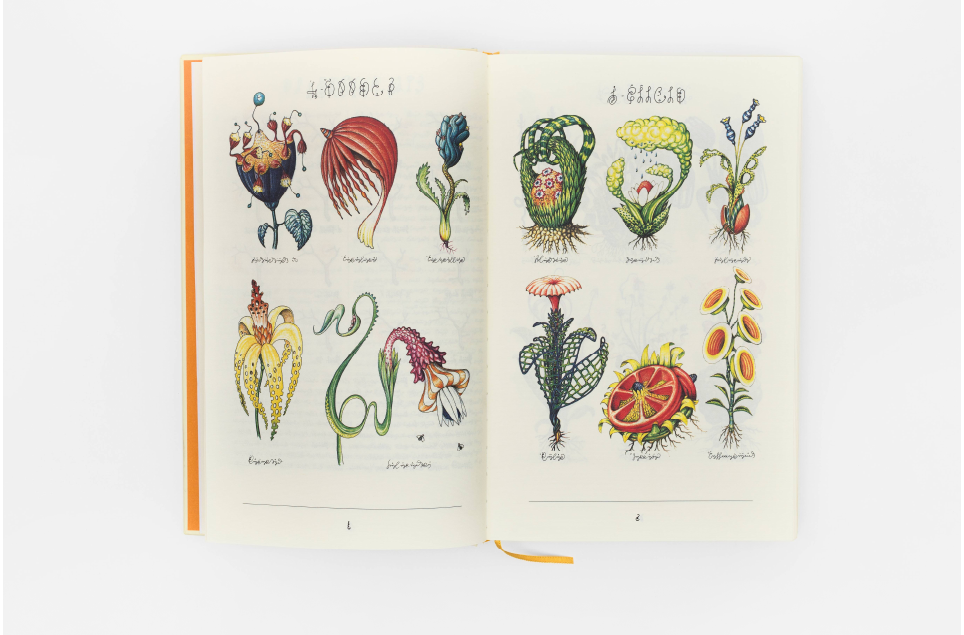
Figure 5. Serafini L. (1981), Codex Seraphinianus , Franco Maria Ricci Editore,